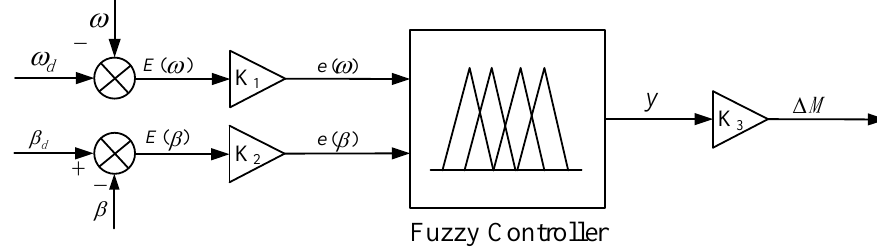
Figure 6. Additional yaw moment calculation based on a fuzzy controller.